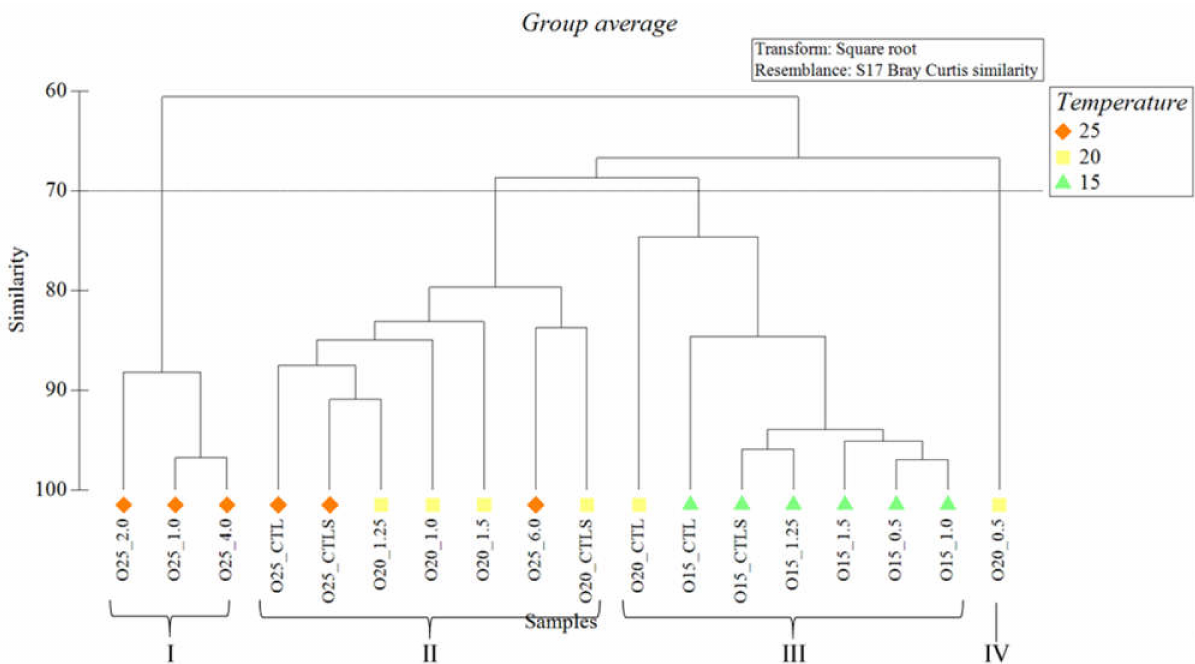
Figure 8. Cladogram (cluster analysis) grouping the diatom’s treatments, related with the neutral sugar content after the exposure to oxyfluorfen at 15 ◦ C, 20 ◦ C, and 25 ◦ C.